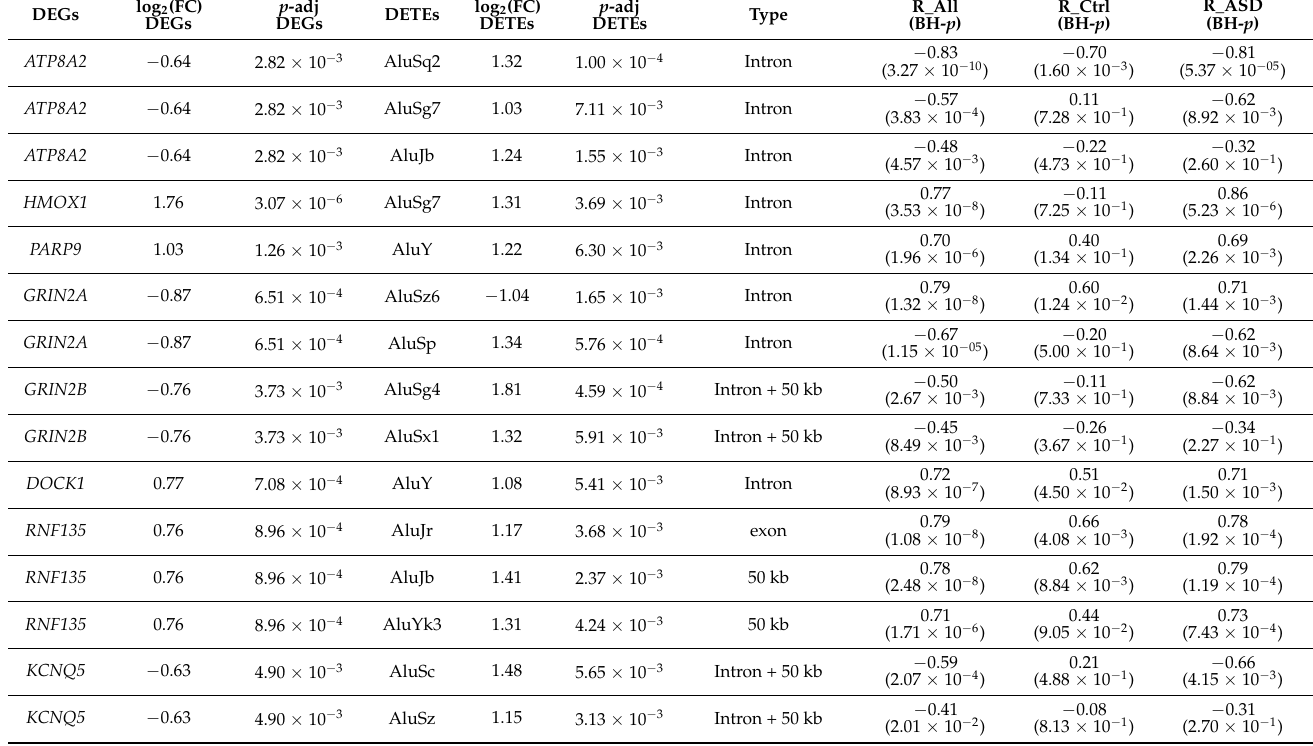
Table 5. Details of selected DEGs and DETEs from correlation analysis (cis-regulation) using RNA-seq data from the prefrontal cortex of ASD and unaffected